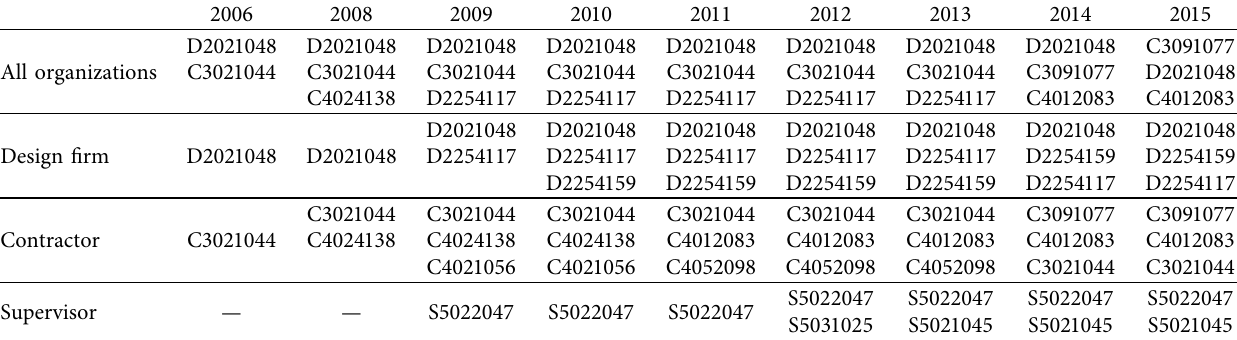
Table 4: Organisations of the first-tier degree centrality (top 3) each year.